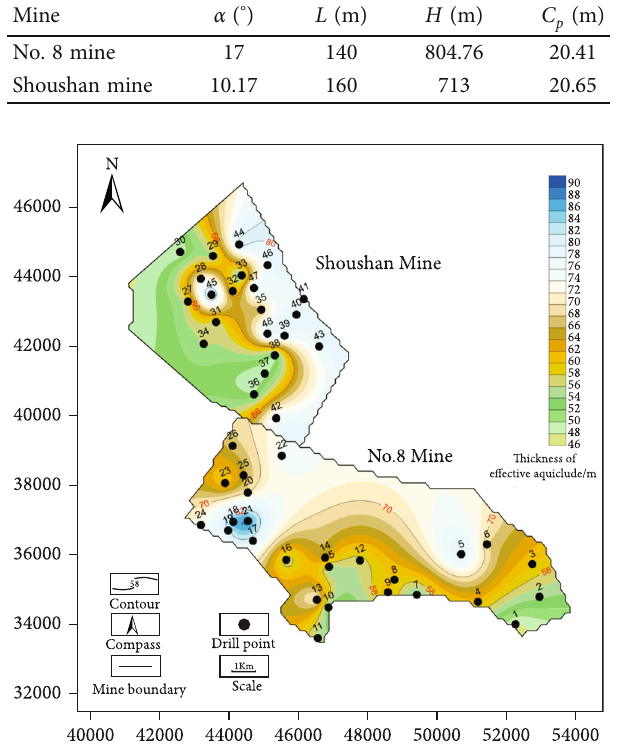
Figure 2: Contour map of the thickness of the e ff ective